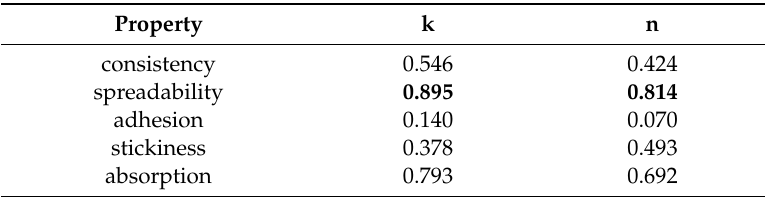
Table 10. Correlation coe ffi cients among rheological and sensory parameters. Statistically significant relations are in